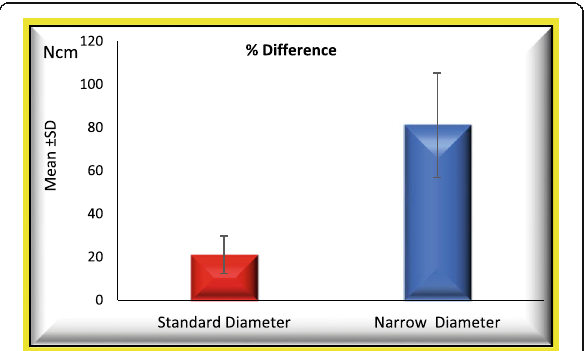
Fig. 3 Mean of percentage difference between initial and post load RTL 1 for GI and GII